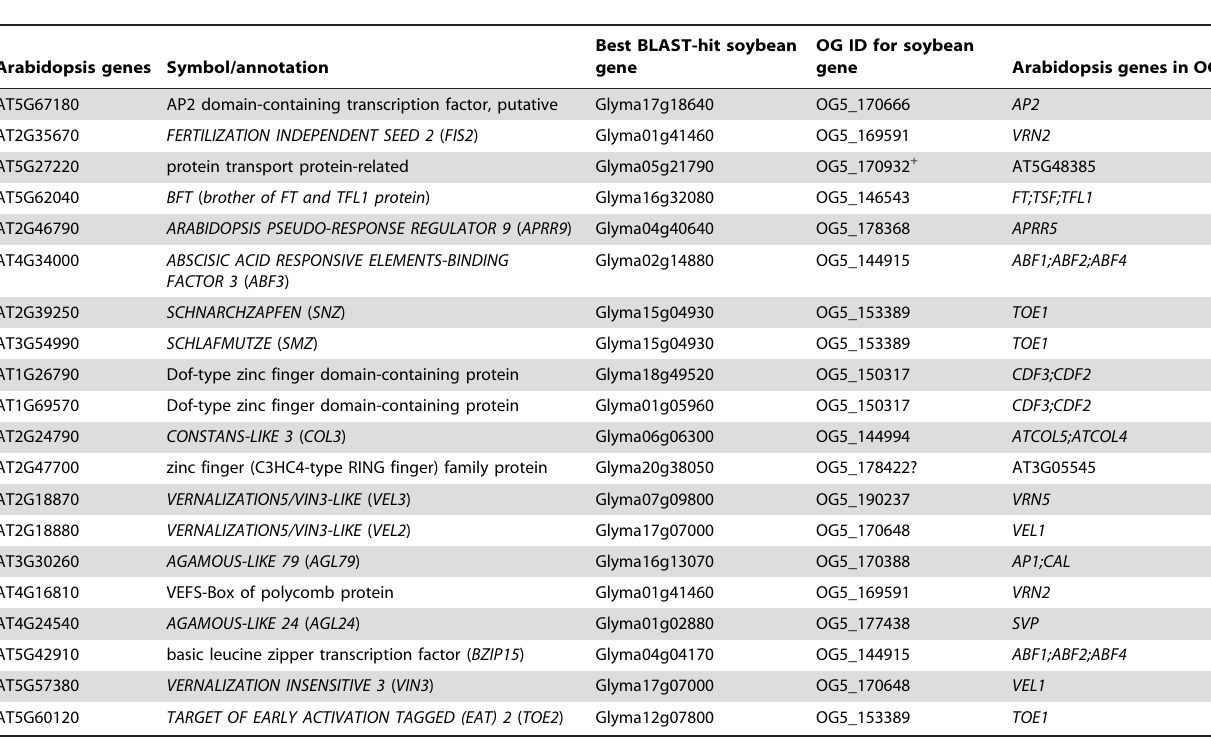
+ Not among the OGs containing Arabidopsis flowering genes. doi:10.1371/journal.pone.0038250.t004 PLoS ONE |